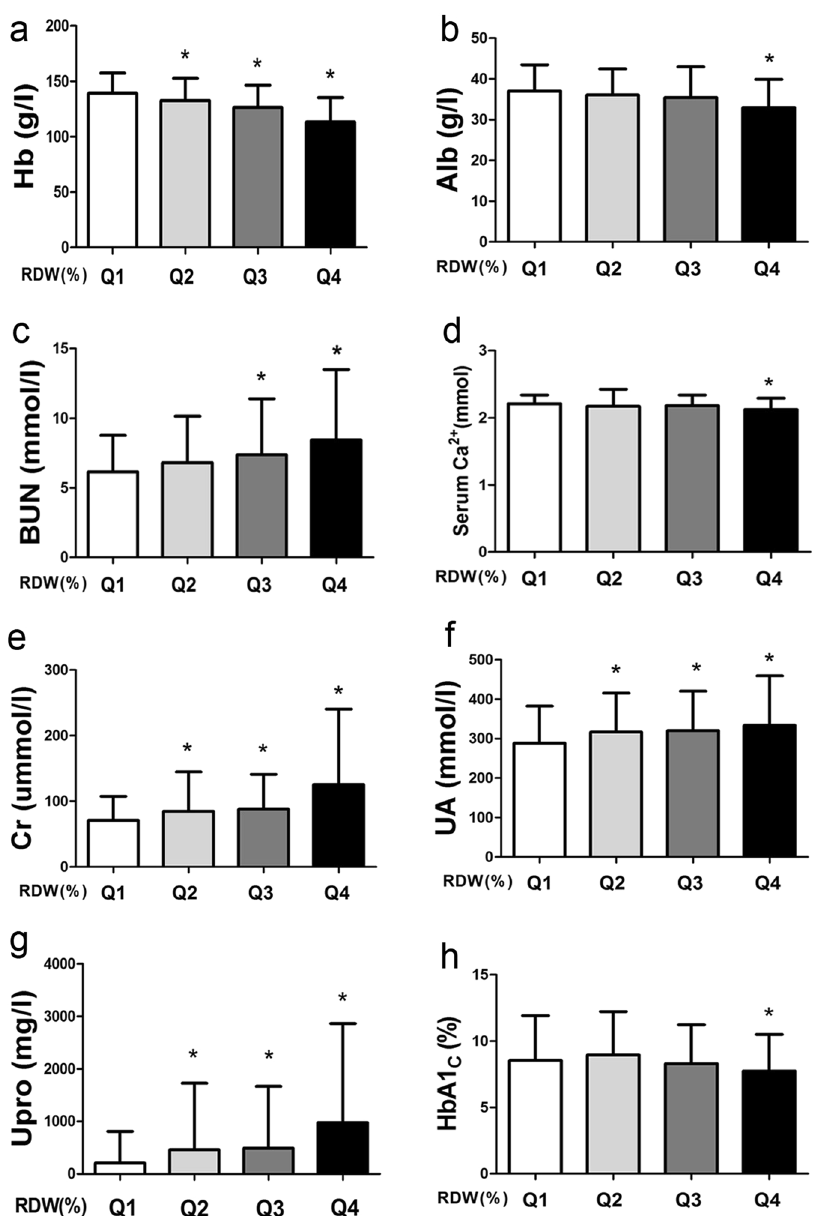
Figure 2. Laboratory results of blood and urine in T2D patients. ( a ) Distribution of Hb levels in Q1 to Q4; ( b ) Distribution of Alb levels in Q1 to Q4; ( c ) Distribution of BUN levels in Q1 to Q4; ( d ) Distribution of serum Ca 2 + levels in Q1 to Q4; ( e ) Distribution of Cr levels in Q1 to Q4; ( f ) Distribution of UA levels in Q1 to Q4; ( g ) Distribution of Upro levels in Q1 to Q4; ( h ) Distribution of HbA1c levels in Q1 to Q4. * P value less than 0.05 compared with the Q1. Abbreviation: Hb, hemoglobin; Alb, serum albumin; BUN, blood urea nitrogen; Serum Ca 2 + : Serum calcium; Cr, serum creatinine; UA, uric acid; Upro, urinary protein excretion; HbA1c, glycosylated